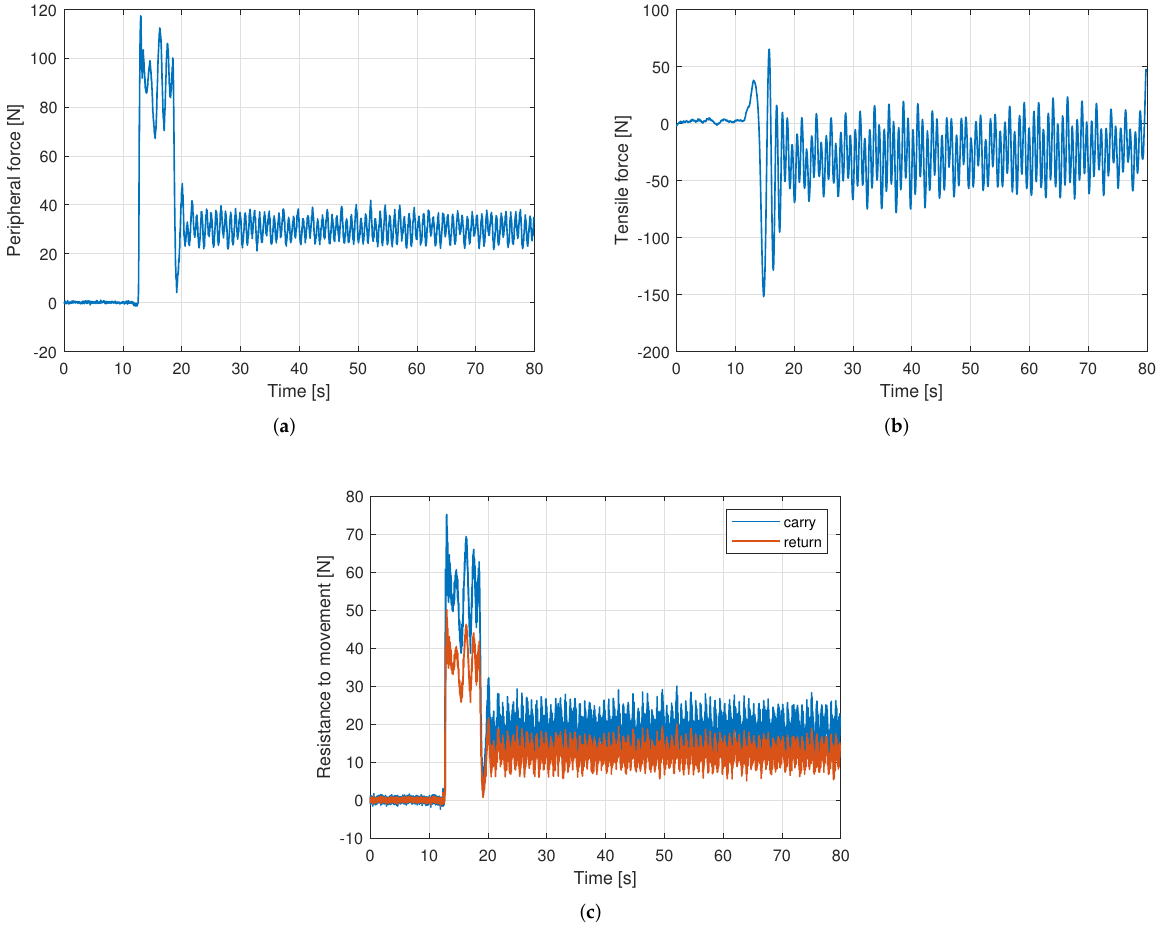
Figure 6. Determination of resistance to motion of the intermediate drive belt sides: ( a ) peripheral force at the drive pulley, ( b ) change of the belt tensile force at the take-up (return) pulley, ( c ) resistance to motion of the carry and return